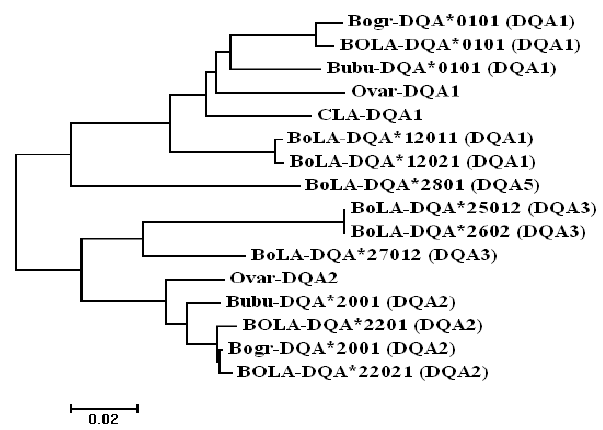
Figure 2. Phylogenetic tree based on DQA nucleotide sequences of yak (neighbor-joining